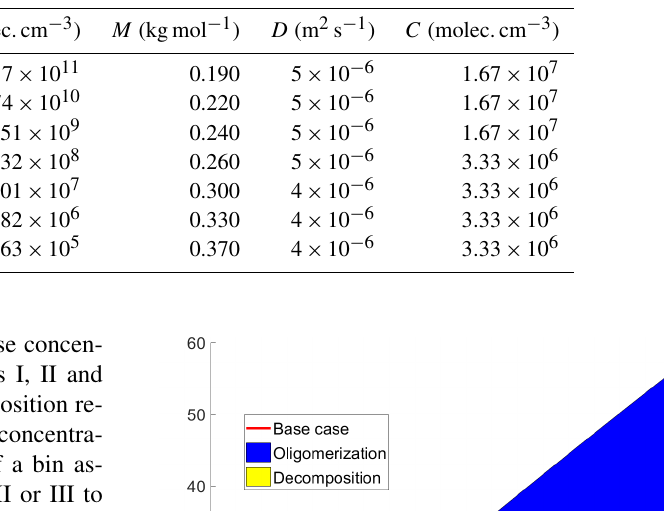
Table 1. The properties of organic model compounds in groups I, II and III, for Case 1, in which the properties are artificial, mimicking atmospheric conditions. C ∗ is saturation concentration, M molar mass, D gas-phase diffusion coefficient and C gas-phase concentration. C ∗ is expressed both in units of micrograms per cubic meter (µgm − 3 ) and molecules per cubic centimeter (molec.cm − 3 ).